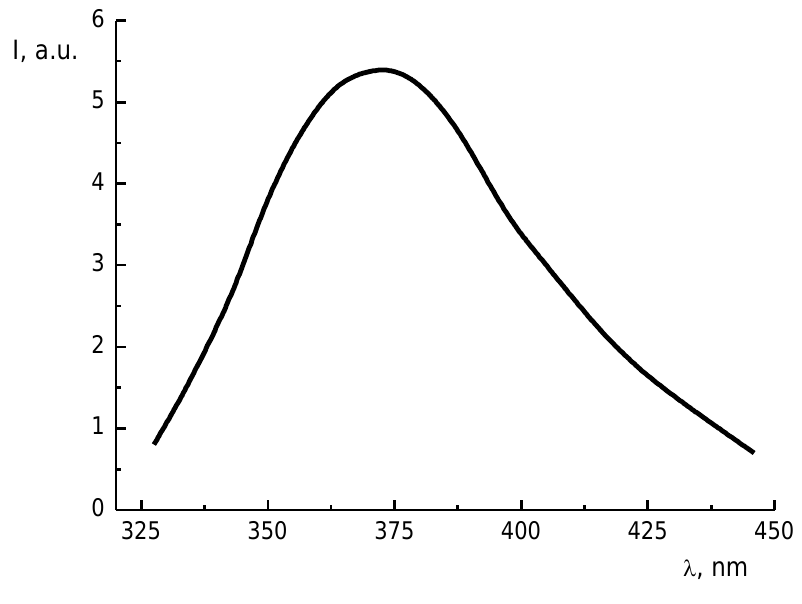
Figure 13. The thermoluminescence spectrum of Li crystals after X-irradiation, obtained for the 150 K peak, from